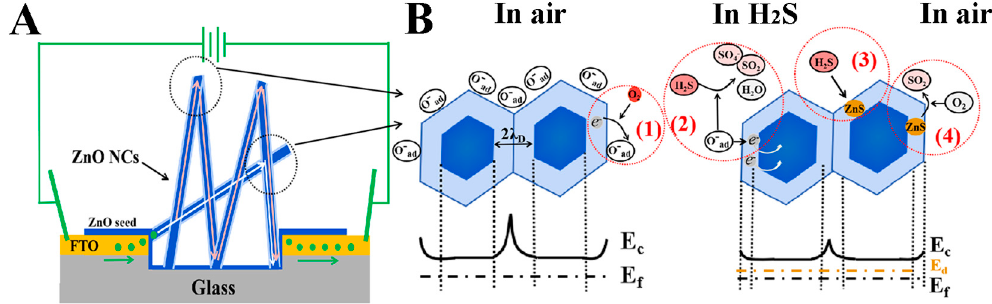
Figure 7. ( A ) Schematic diagrams of the electron transport path of the ZnO NCs gas sensor. ( B ) The model and band diagrams of ZnO NCs sensors exposing in air and H 2 S.